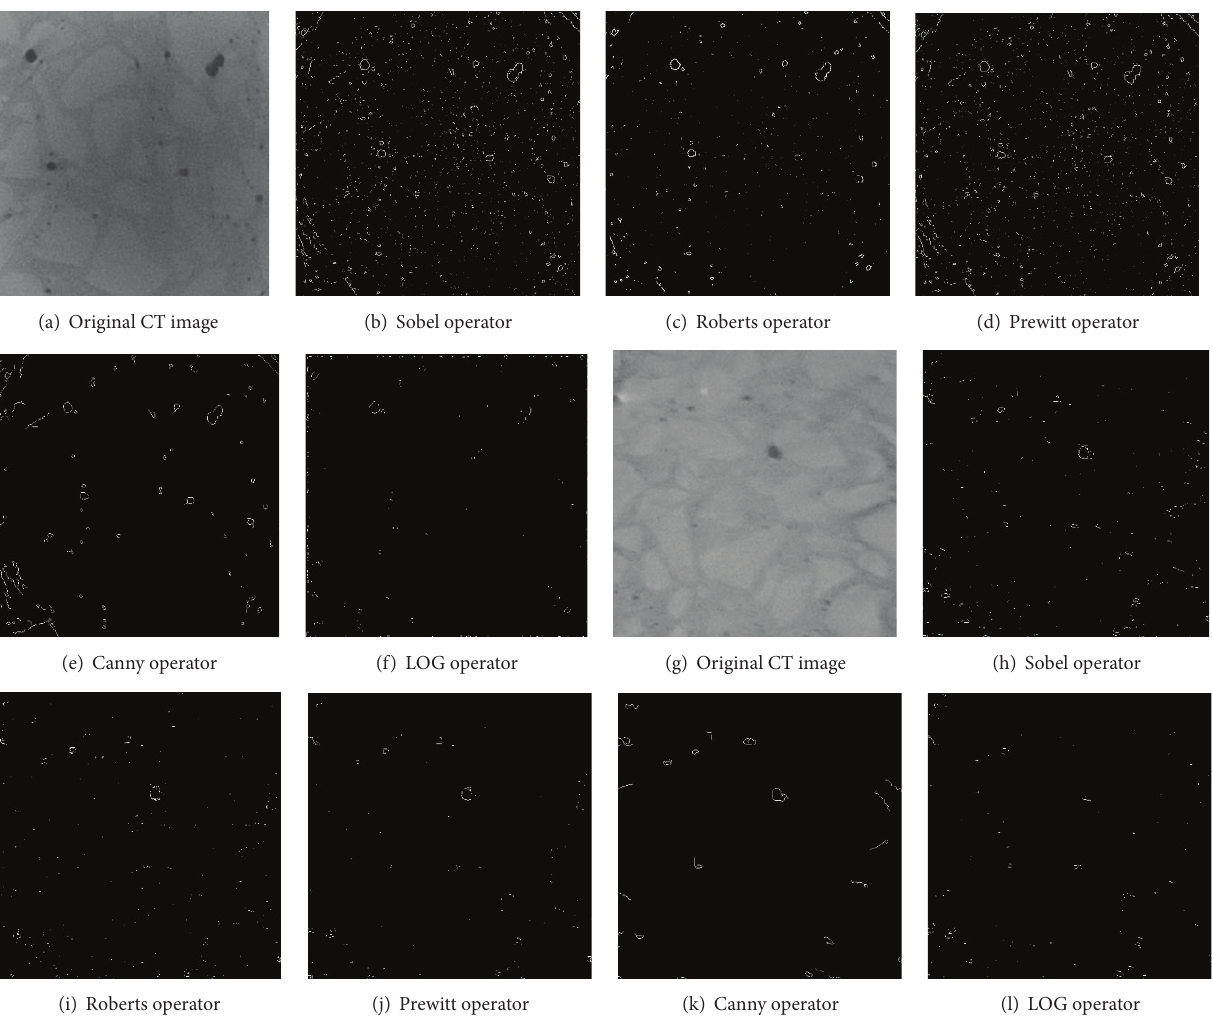
Figure 3: Comparisons of edge detection performance using different edge operators for (a)–(f) original CT image of C30 concrete and the edge image of different operators and (g)–(l) original CT image of C40 concrete and the edge image of different operators,